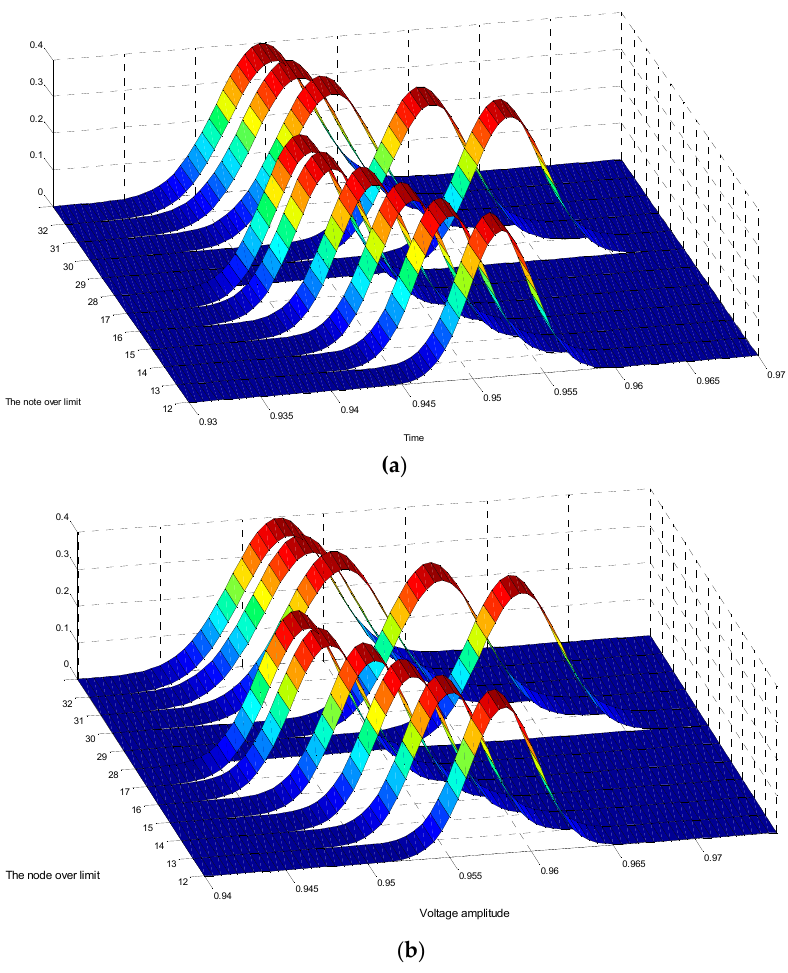
Figure 12. The node over limit at 19:00 p.m . ( a ) Case 2; ( b ) Case 3. Table 4. Risk assessment results of distribution network at 19:00 p.m .